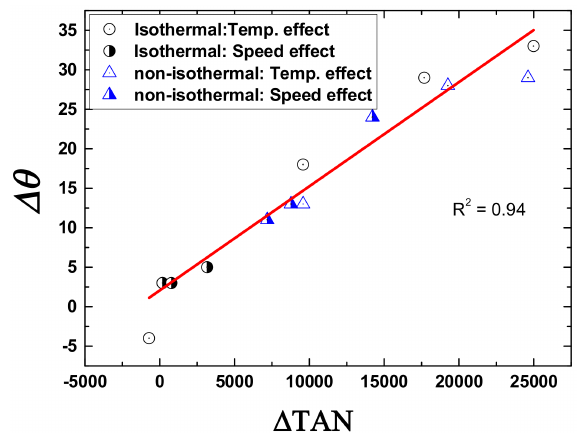
Figure 10. The relationship between ∆ θ and ∆ TAN for isothermal and non-isothermal